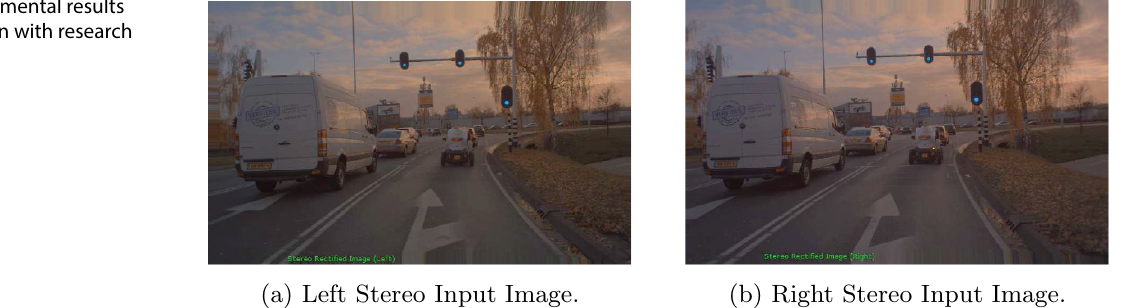
Fig. 15 Experimental results of stereo vision with research vehicle